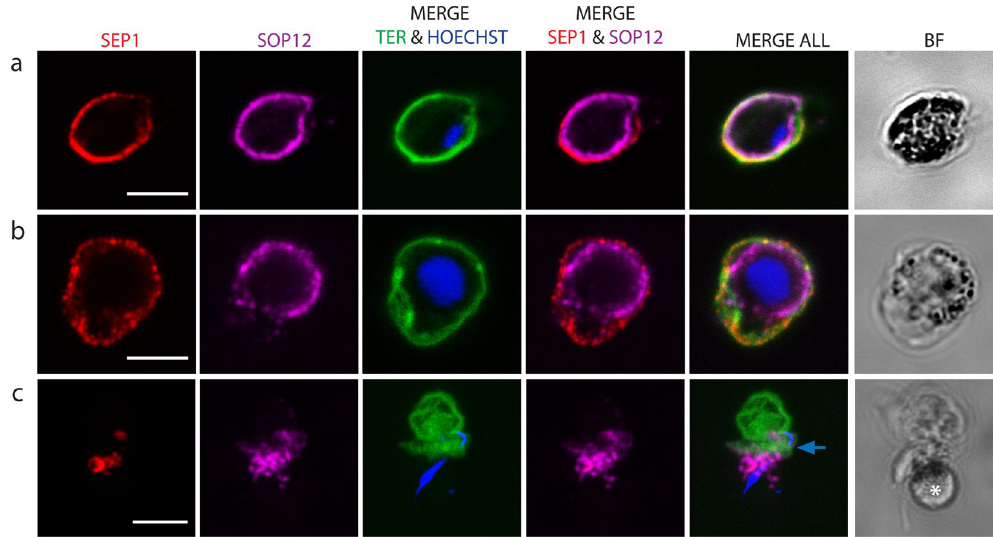
Figure 6. Labeling of SOP12-EGFP gametocytes reveal swelling of PV. The PVM was labeled with the SEP1 antibody (red), the parasite membrane protein SOP12 is highlighted with a GFP antibody (magenta) and the RBCM labeled with TER-119 (green). DNA is stained with Hoechst 33342 (blue). ( a ) Non-activated gametocyte. SOP12 is localized adjacent to the PVM and RBCM. ( b ) Activated gametocyte. The RBCM and PVM are extended, indicating the swelling of the PV and shrinking of the RBC cytoplasm. SOP12 is delineating the gametocyte. ( c ) Exflagellating male. The SOP12 label is no longer clearly delineated suggesting that the protein is secreted. Blue arrow shows the RBC membrane vesicles and above them there is another intact RBC. White asterisk shows the parasite. Projections of confocal stacks through the middle of the cell in a and b, and through the whole cell in c. Scale bar, 5 µ m.